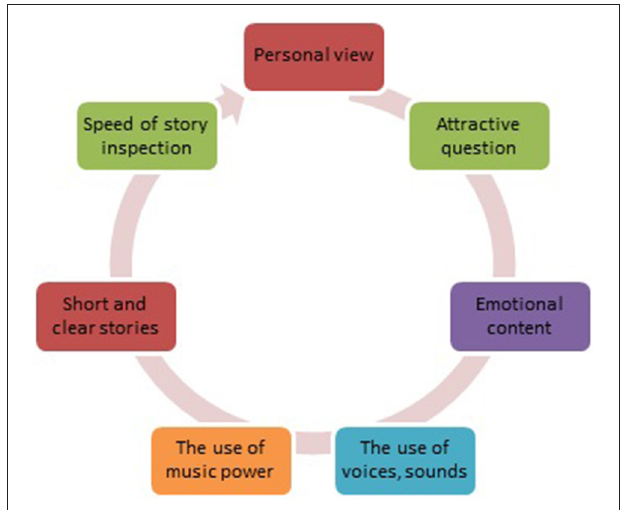
FIGURE 1 | The type of digital stories used is to teach and inform.